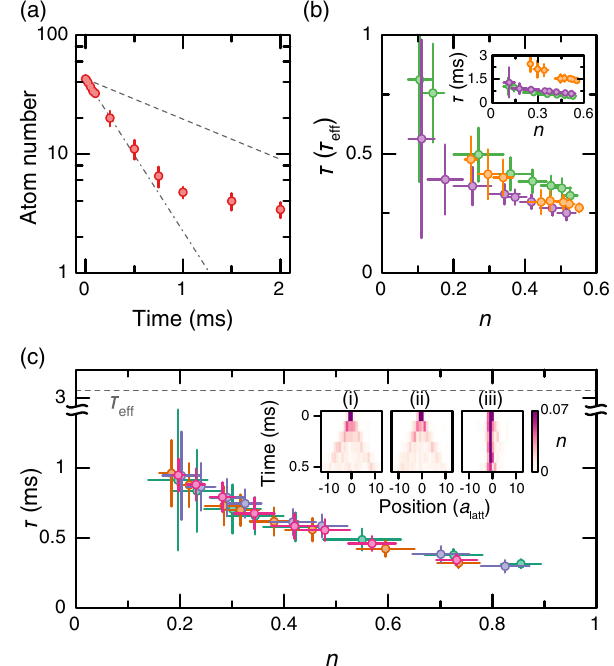
FIG. 3. Lifetime of itinerant Rydberg-dressed fermions. (a) Atom number vs dressing time for a frozen gas. The red circles correspond to measurements on a system of ( 7 × 7 ) sites. Dashed-dotted line corresponds to an exponential fit to the first five data points, and dashed line corresponds to the expected single-particle dressed lifetime τ . (b) Measured lifetime in a eff frozen gas in units of τ vs the initial density for eff Ω ¼ 2 π × 9 . 25 ð 8 Þ MHz and Δ ¼ 2 π × ½ 30 ð green Þ ; 40 ð purple Þ ; 60 ð orange Þ(cid:2) MHz. Inset: same measurements in units of ms. (c) Lifetime vs initial density for different tunnelings: 0.01 kHz (green), 0.25 kHz (purple), 1.0 kHz (orange), and 1.7 kHz (pink). The data are taken with Ω ¼ 2 π × 6 . 04 ð 8 Þ MHz, Δ ¼ 2 π × 30 MHz. Insets: (i) Tunneling dynamics of atoms sparsely initialized on a strip along the y direction with no dressing light. From these data, we extract a tunneling rate t ¼ h × 1 . 7 kHz. (ii) Same measurement in the presence of the dressing light. (iii) Same measurement in the presence of the dressing light but with the strip along the x direction. Experimental error bars correspond to the standard error of the